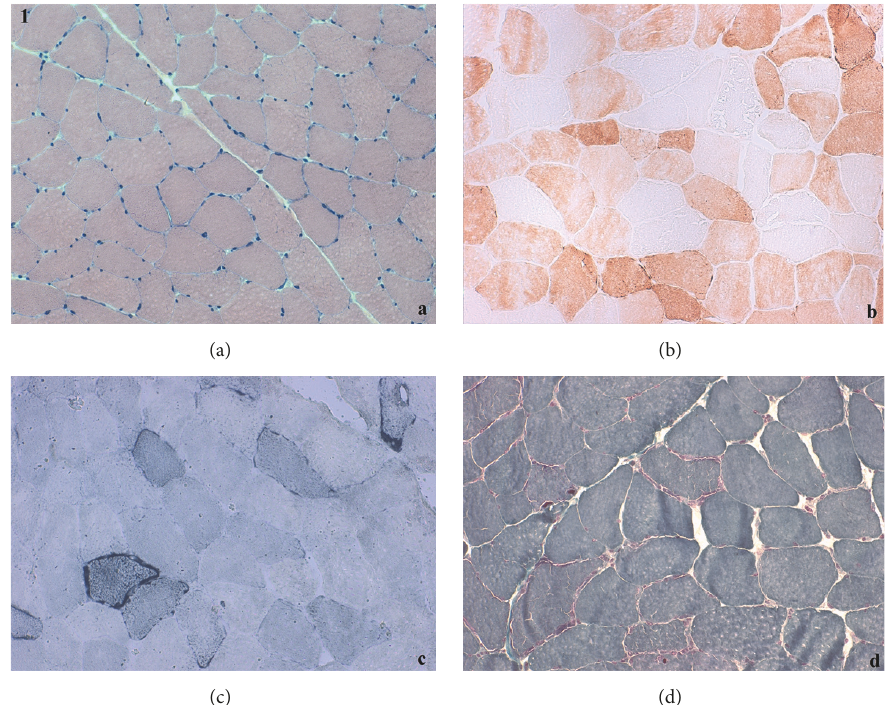
Figure1:Musclebiopsy:(a)hematoxylineosin;(b)stainingforcytochromeoxidase;(c)Succinatedehydrogenase(SDH)staining;(d)G¨om¨ori trichrome stain.